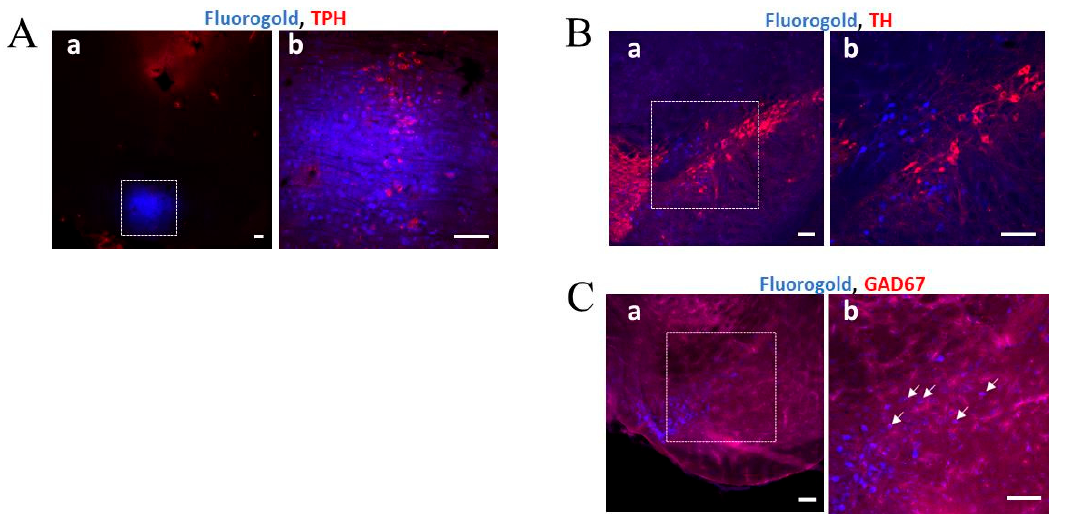
Figure 4. Retrograde labeling of neurons following fluorogold (FG) injection into the median raphe nucleus (MnRN). ( A ) The square on the confocal laser-scanning microscope images under low (a) and high (b) magnification indicates the MnRN region at 3 days after FG injection. The image shows that FG (blue) was precisely injected into the MnRN. Tryptophan hydroxylase (TPH)-positive cells (red) were observed in the MnRN. Scale bar: 100 µ m. ( B ) and ( C ) The square on the photomicrograph taken under low (a) and high (b) magnification indicates the substantia nigra pars compacta (SNpc) ( B ) and the reticular part of the substantia nigra (SNr) ( C ), which were analyzed using a confocal laser-scanning microscope at 3 days after FG injection. Scale bar: 100 µ m. FG-labeled cells (blue) ( B -a and -b, C-a and -b) and GAD67-positive cells (red) ( C -a and -b) were co-localized in the SNr regions (indicated by white arrows) ( C -b), but TH-positive cells (red) ( B -a and -b) were not co-localized in the SNpc